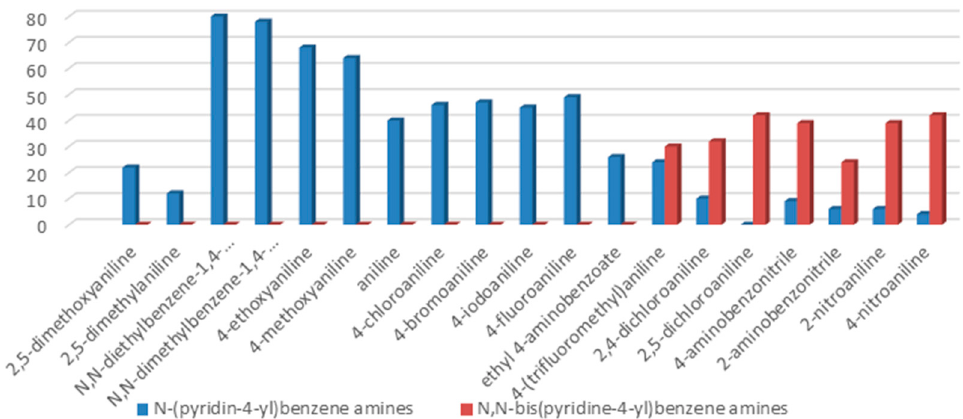
Figure 1. Comparison of yields for different aromatic amines in C-N coupling reaction with 4-chloropyridine in the presence of K 2 CO 3 as a base.